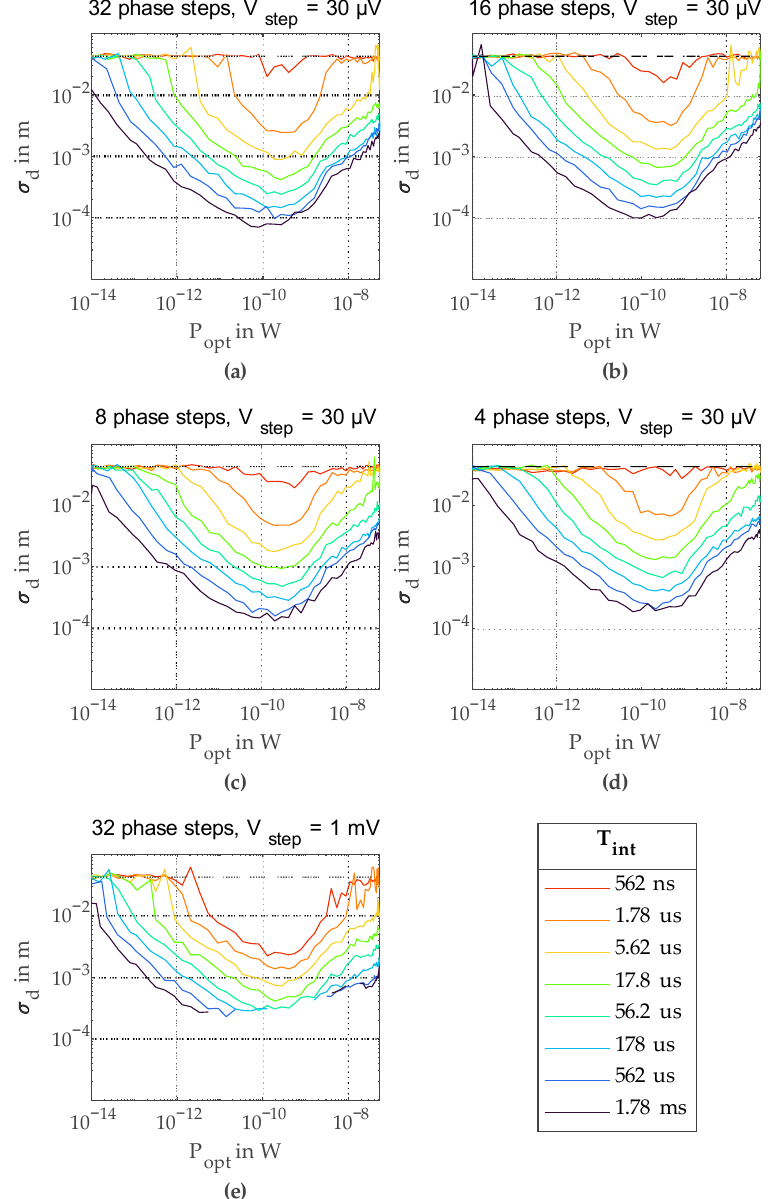
Figure 6. Standard deviation σ d over P opt for different T int .: ( a ) with 32 phase steps, V step = 30 µ V; ( b ) with 16 phase steps, V step = 30 µ V; ( c ) with 8 phase steps, V step = 30 µ V; ( d ) with 4 phase steps, V step = 30 µ V; ( e ) with 32 phase steps, V step = 1